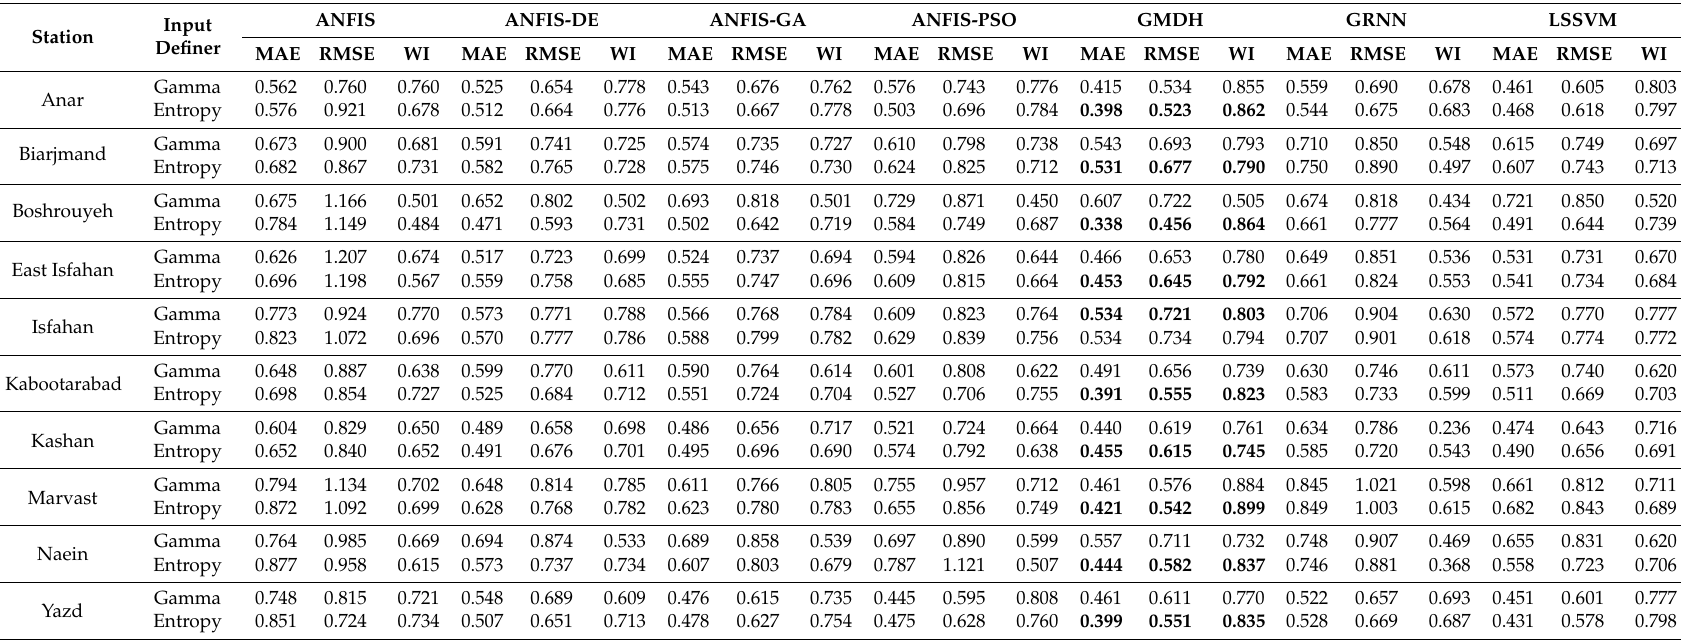
The bold numbers are the best performance of each station, on its own